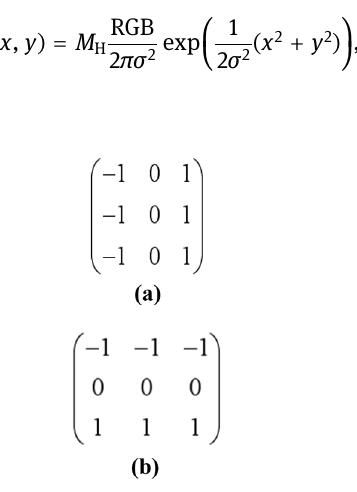
Figure 2: Two templates. ( a ) Horizontal di ff erence template and ( b ) vertical di ff erence